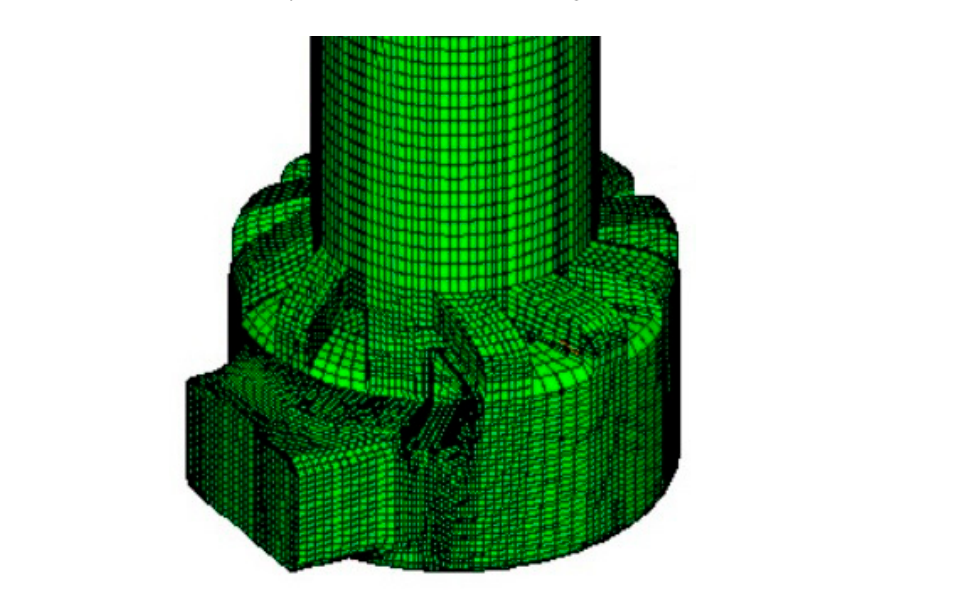
Figure 7. Layout of the 2-stroke RCCI engine.